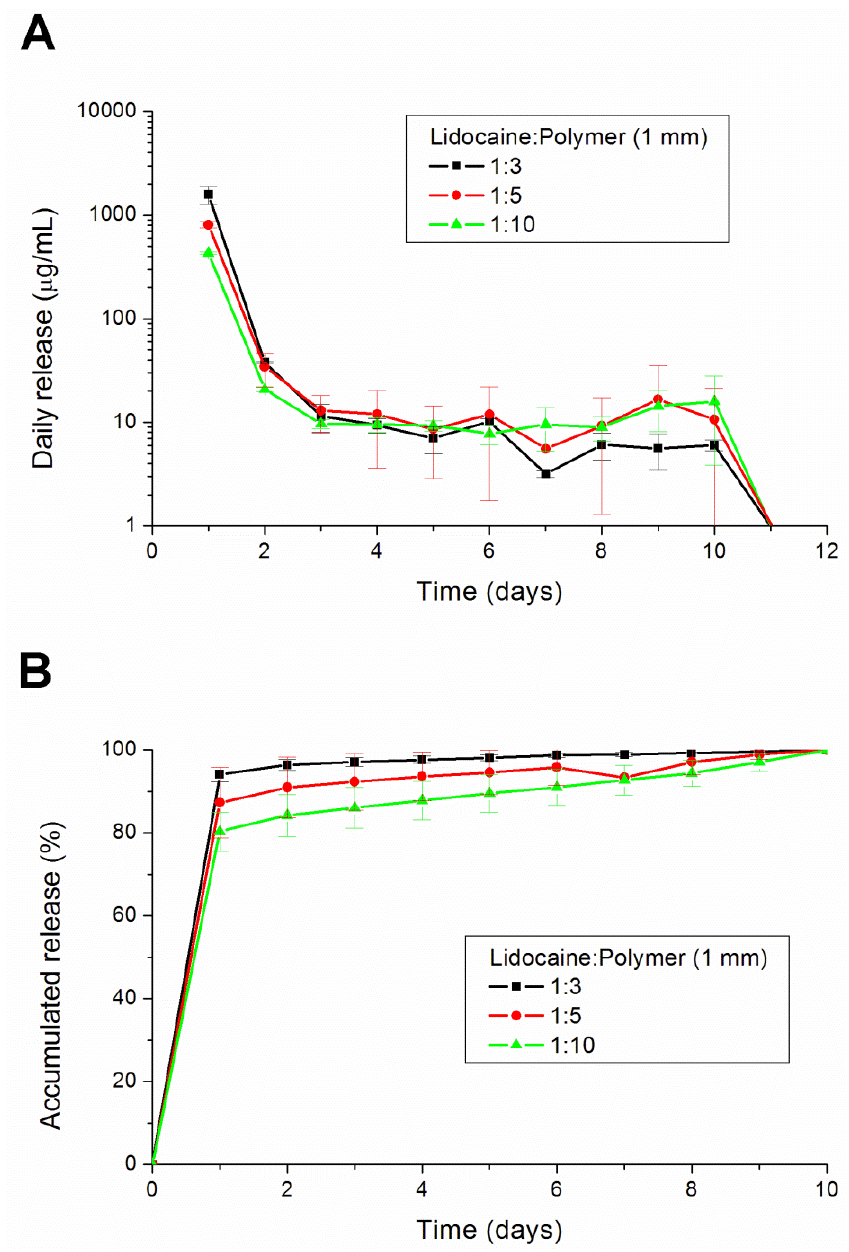
Figure 5. The ( A ) daily and ( B ) accumulated release kinetics of the three different ratios (1:3, 1:5 and 1:10) of the lidocaine-polymer